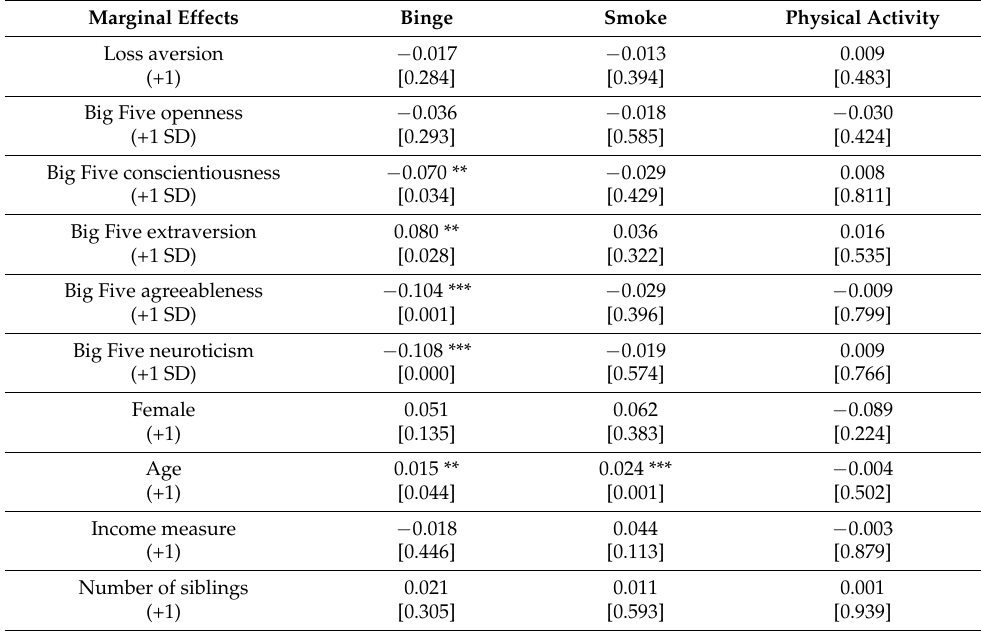
Table 5. US sample, probit regressions, marginal